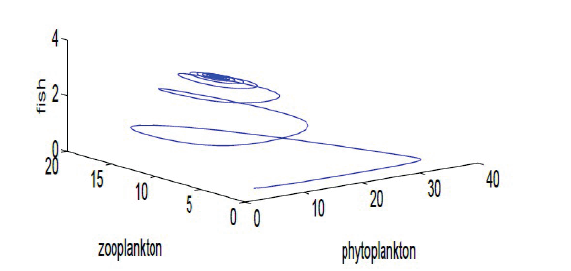
Fig. 1: Convergence of system trajectories around R * at τ = 0